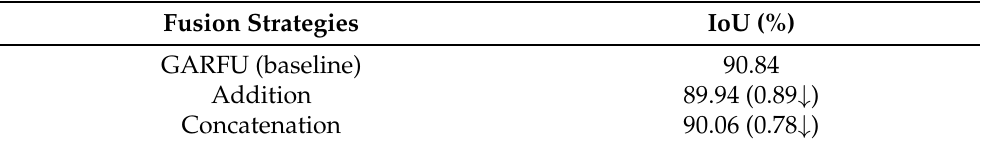
Table 3. Comparison of different fusion strategies on the WHU dataset. ↓ stands for the decrement of the IoU compared with the baseline. Note, OHEM and MS are not used for this